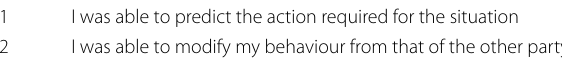
Table 2 Human–Machine collaboration qualitative evaluation